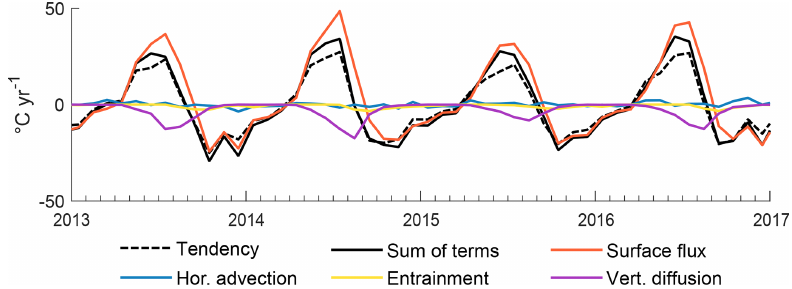
Figure A1. The dominant terms of the ECCOv4-r4 mixed-layer temperature budget from 2013–2016 ( ◦ Cyr − 1 ), averaged over the cold blob region. The dashed black line shows the model temperature tendency, and the solid black line shows the sum of the temperature budget terms driving the temperature change. The remaining lines represent these individual processes: the surface heat flux (orange), horizontal advection (blue), vertical entrainment (yellow), and vertical diffusion (purple). Lateral induction and horizontal diffusion are not shown because both are negligible.